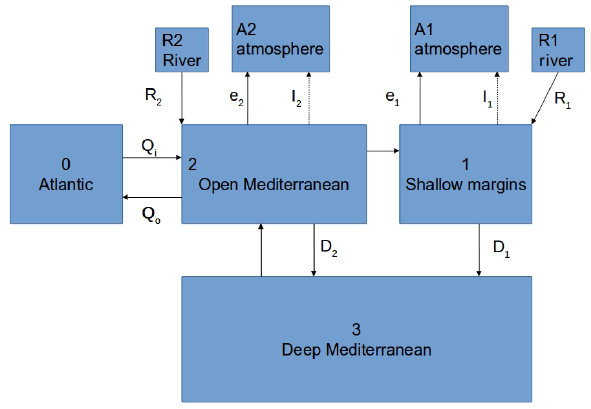
Figure 2. A schematic overview of the model set-up. The unla- belled fluxes are balancing fluxes, and the equations for all fluxes are given in Sect. 2.3. The direction of the arrows indicates the pos- itive direction in the equations; all horizontal fluxes can change di-